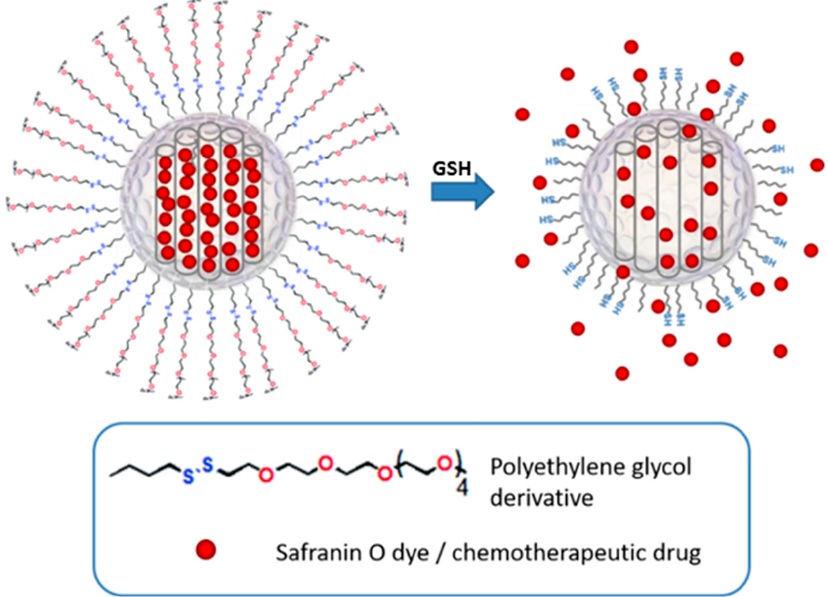
Figure 1. Schematic representation of the gated material (S2 and S3) capped with PEG chains via disul fi de linkage, and its activation with intracellular GSH.